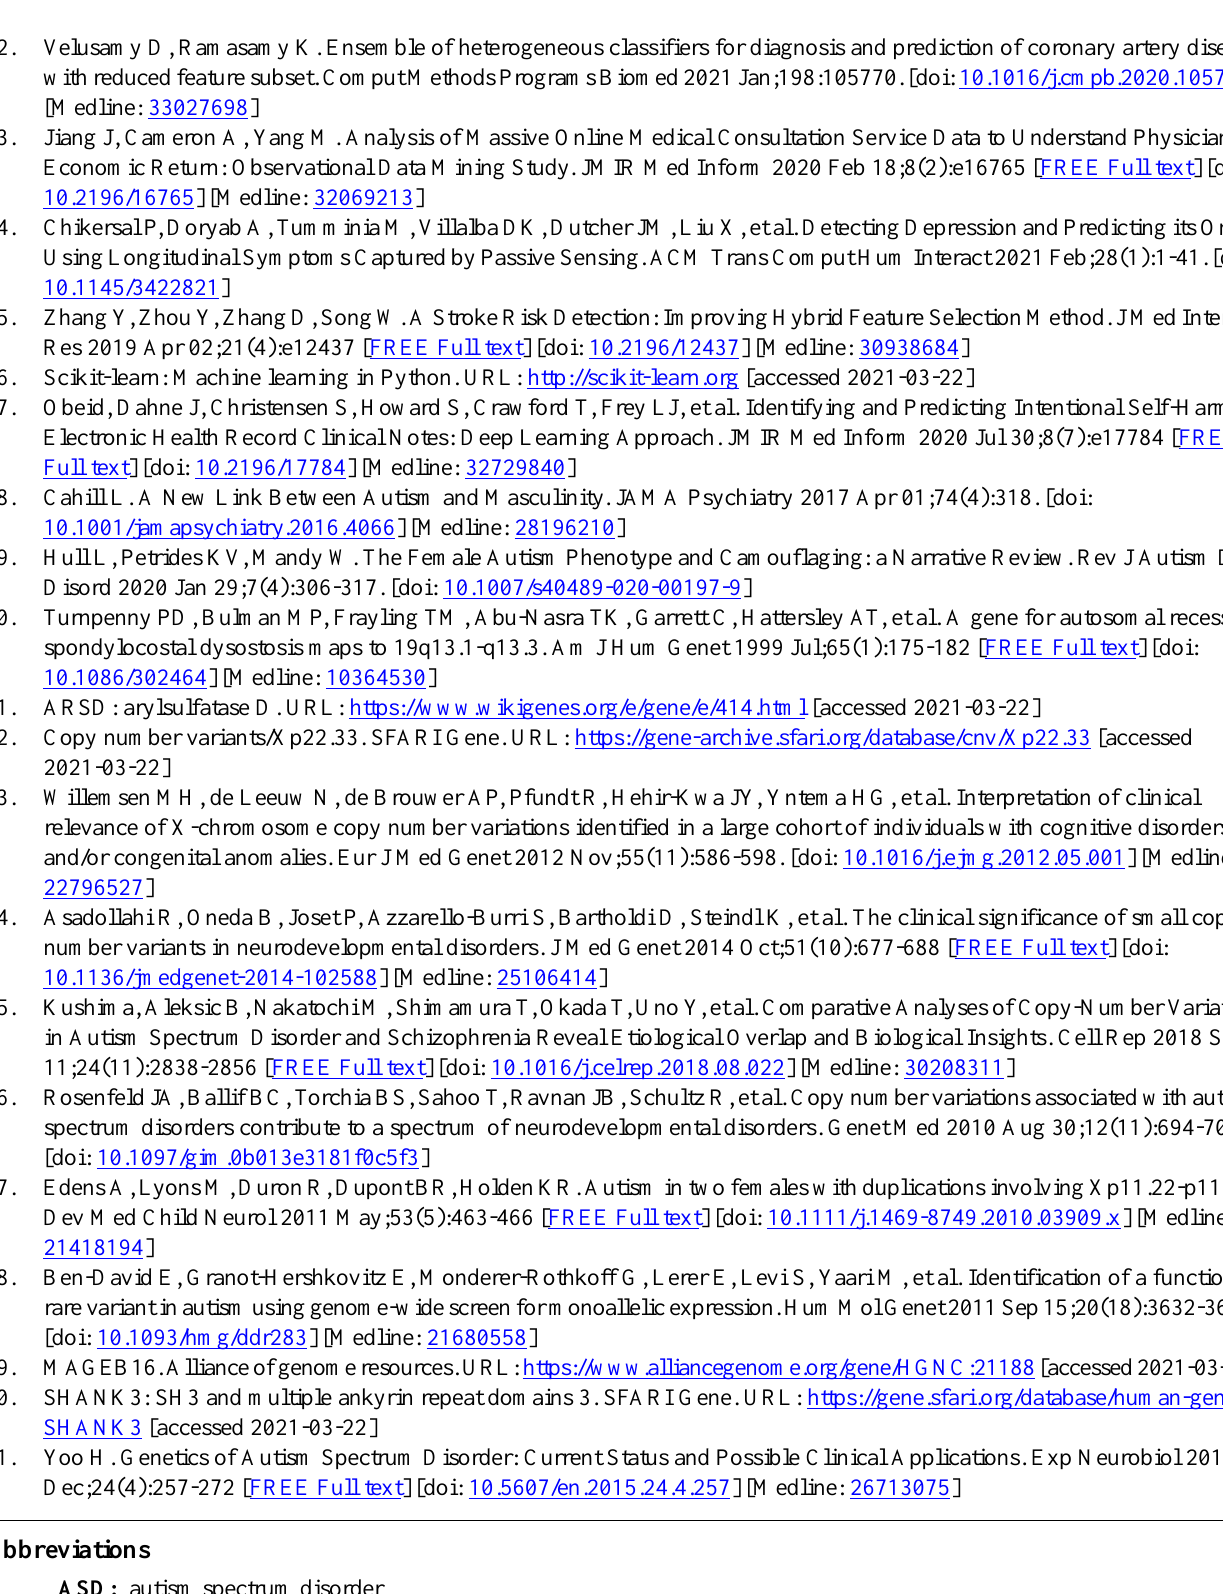
Abbreviations ASD: autism spectrum disorder AUC: area under the receiver operating characteristic curve CNN: convolutional neural network SSC: Simons Simplex